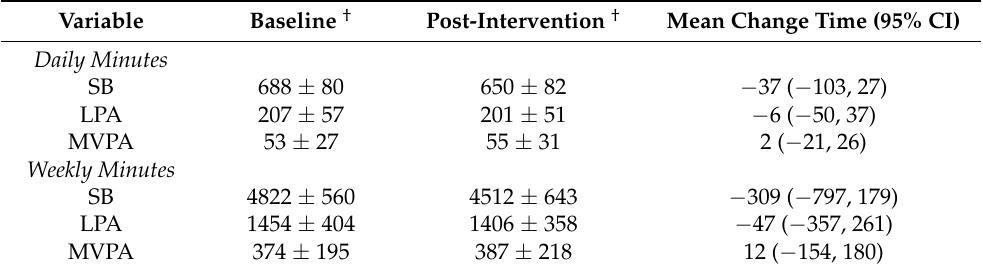
Table 4. Time Spent in Sedentary Behavior and Physical Activity during the Telehealth